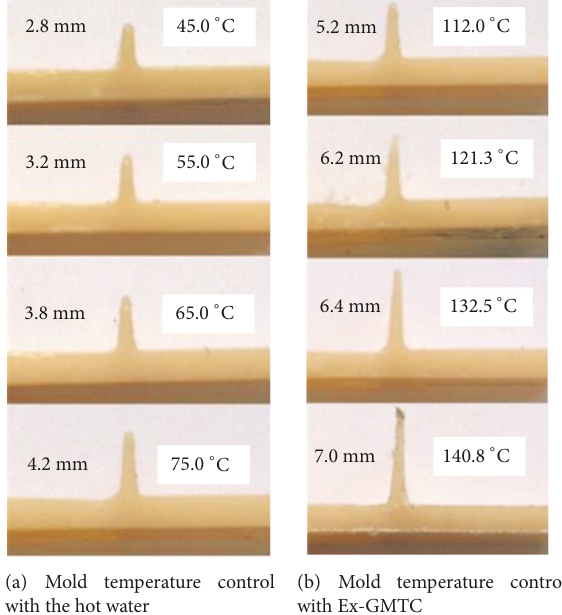
Figure 21: Measurement of thin rib height at different cavity